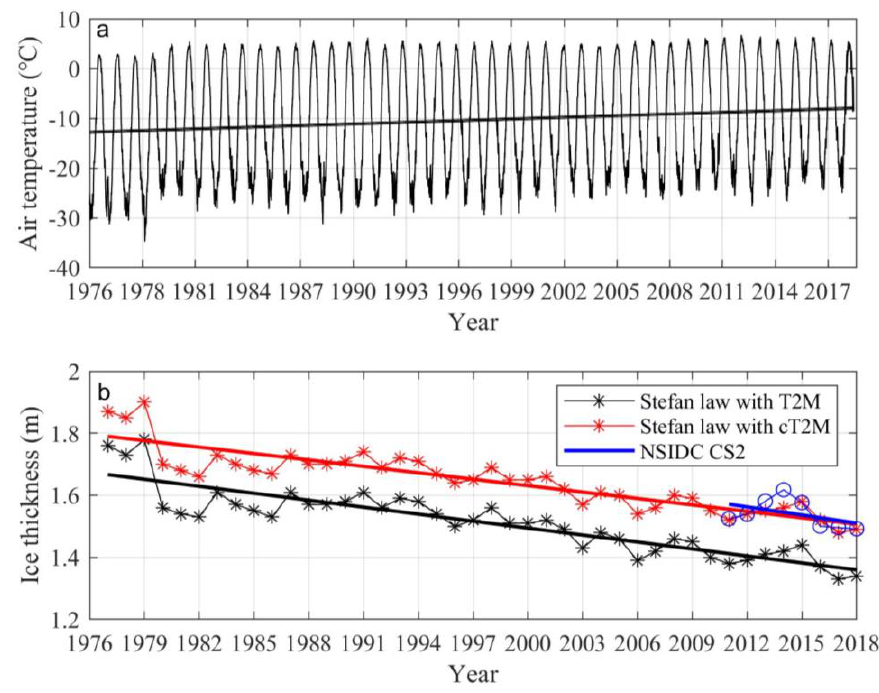
Figure 10. ( a ) T2M averaged in the landfast ice grid cells and the ( b ) mean April landfast ice thickness calculated by Stefan’s law with T2M (black stars), by Stefan’s law with corrected T2M (cT2M) (red stars) and obtained from the NSIDC CS2 product (blue circles). The lines represent the linear trends.